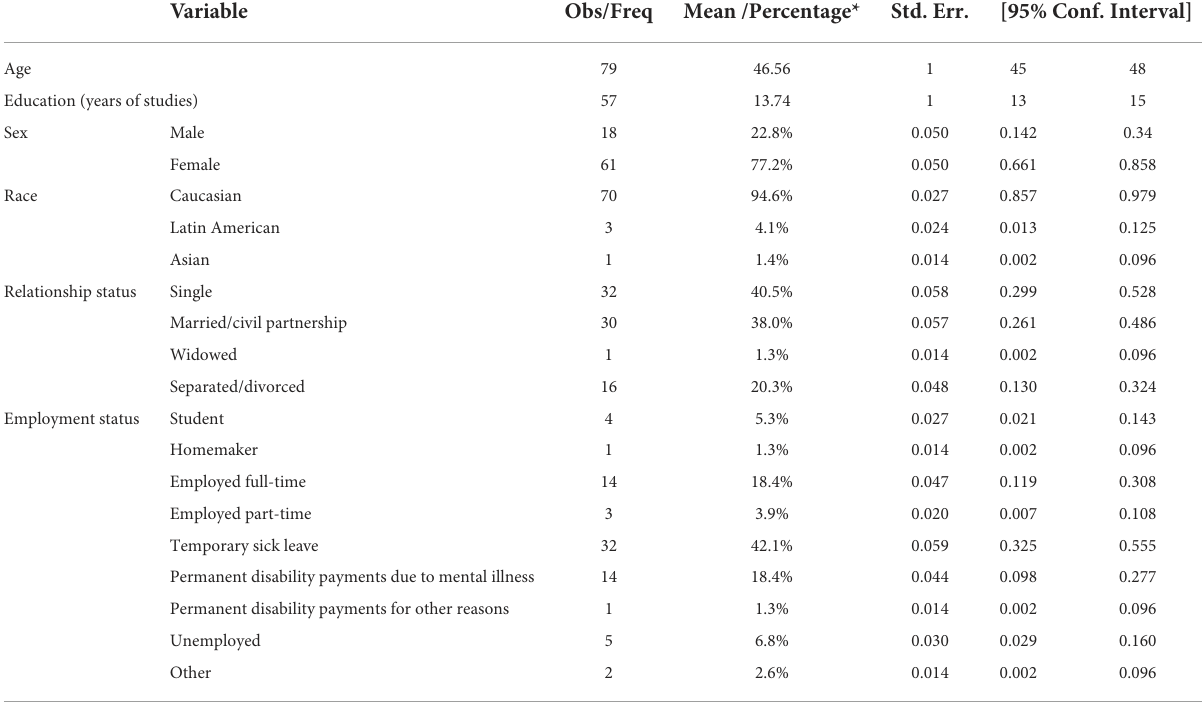
TABLE 1 Sociodemographic characteristics of the sample. Variable Obs/Freq Mean /Percentage* Std.